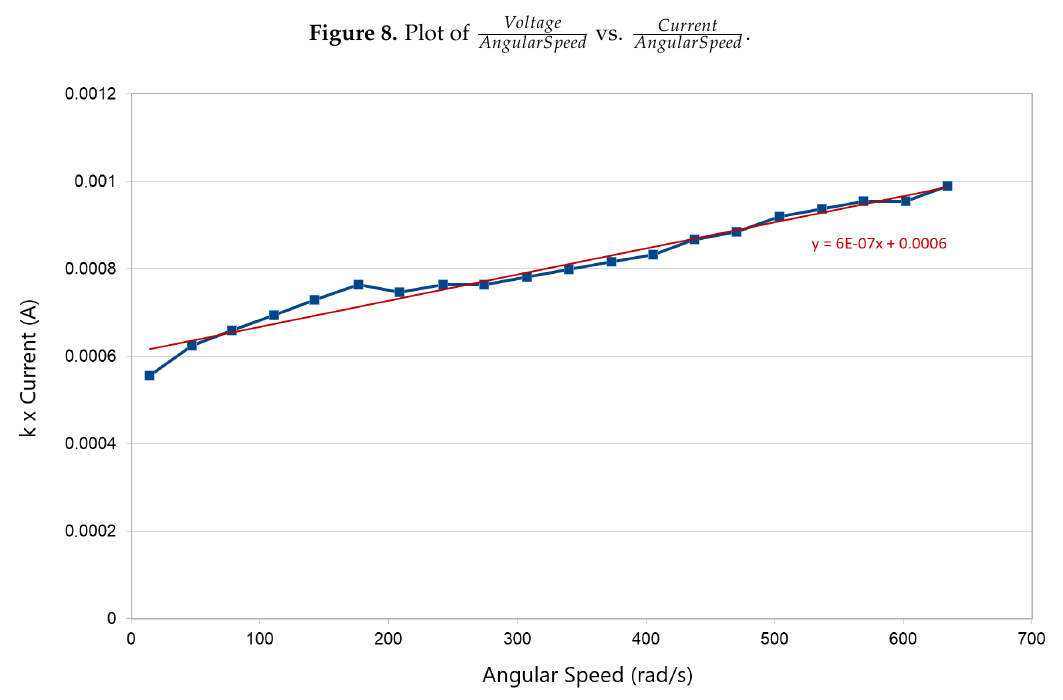
Figure 8. Plot of Voltage